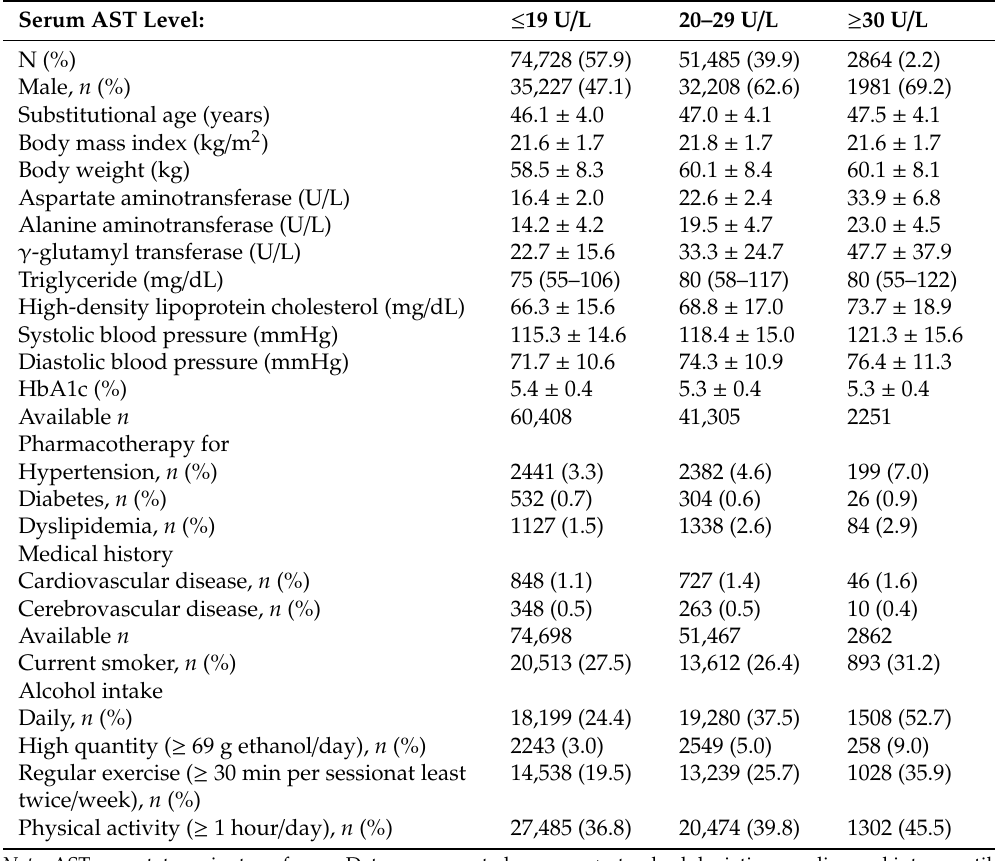
Table 1. Baseline characteristics of younger subjects.